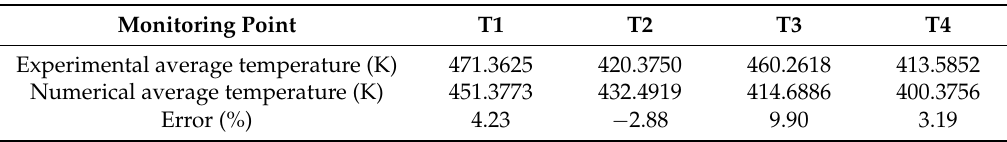
Table 1. Comparison between experimental data and numerical data.